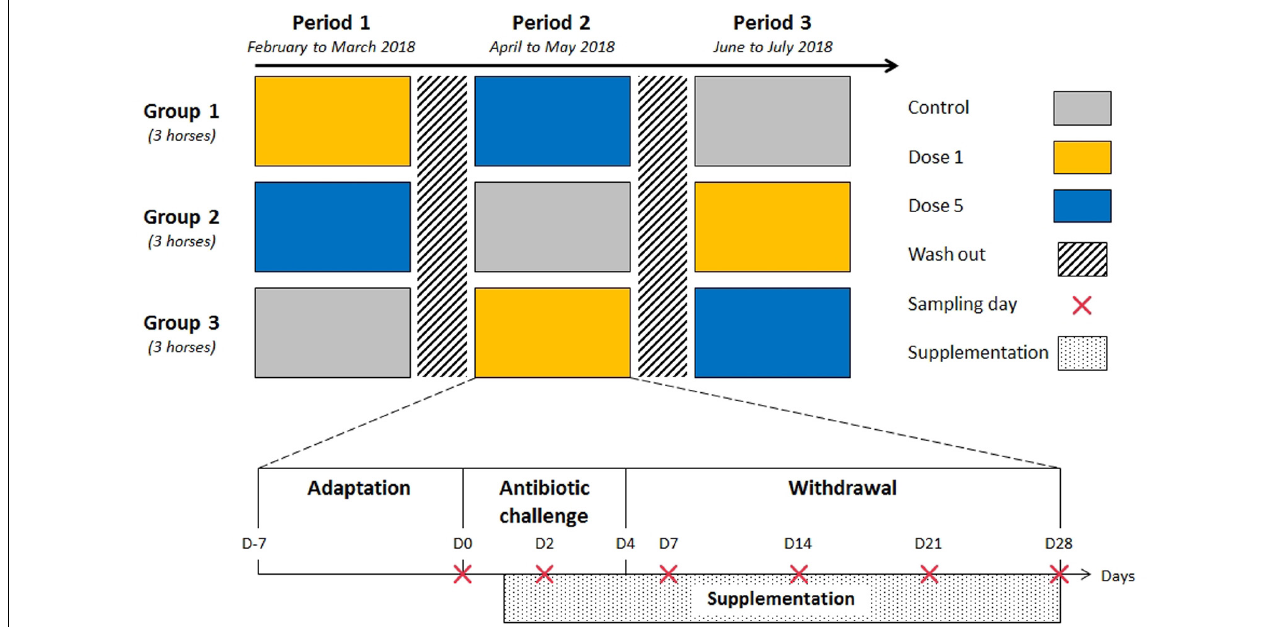
FIGURE 1 | Outline of the trial design and experimental periods. Each experimental period comprised sample collection and the administration of a feed supplement. Nine adult horses were assigned randomly to one of the three feed supplement modalities for each 5-week period in a 3 × 3 Latin square design. Each period was separated by a 21-day washout